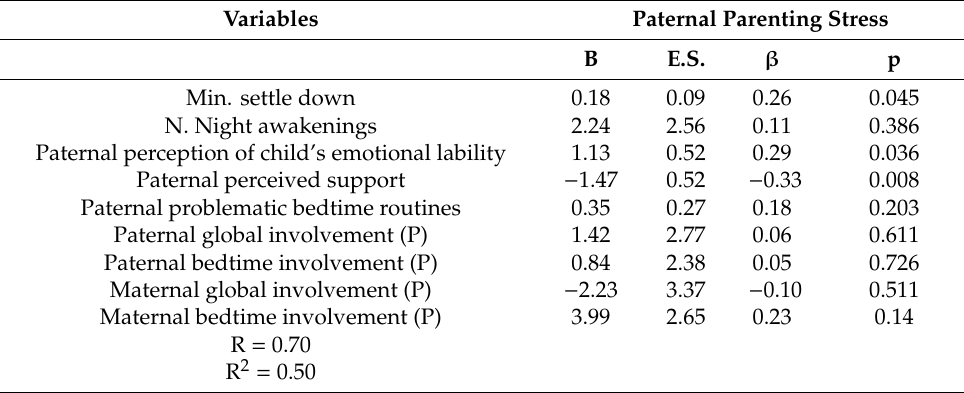
Table 2. Regression coe ffi cients of predictors of paternal parenting stress. Variables Paternal Parenting Stress B E.S. Min. settle down Paternal perception of child’s emotional lability